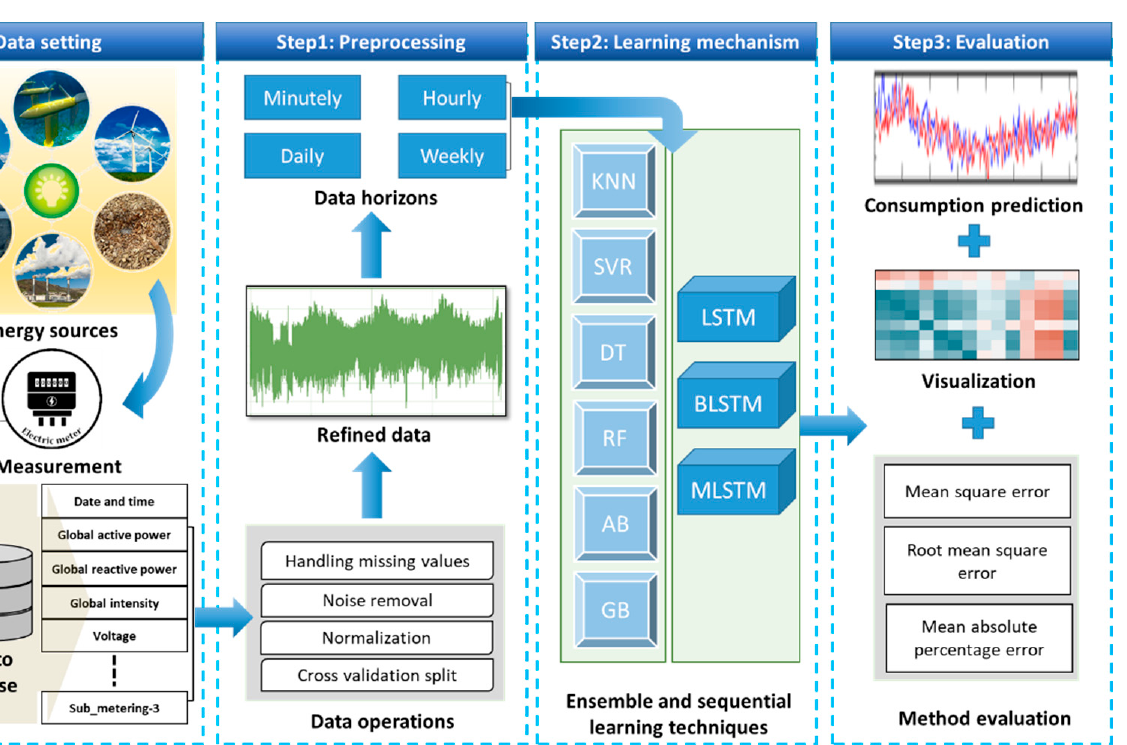
Figure 2. Three-tier ECP framework. At first, the preprocessing step is applied for noise and outlier removal from the data, normalization, and formation of horizons. In the second tier, the model’s learning is carried, which comprises of conventional learning and sequential learning-based methods, while the third tier gives the final prediction of energy, visualization, and performance evaluation using basic metrics.